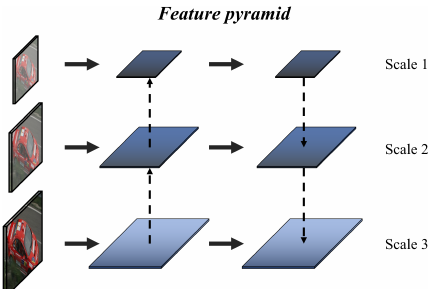
Figure 1. Feature pyramid architecture. A method of fusing extracted feature maps of different scales through upsampling or downsampling